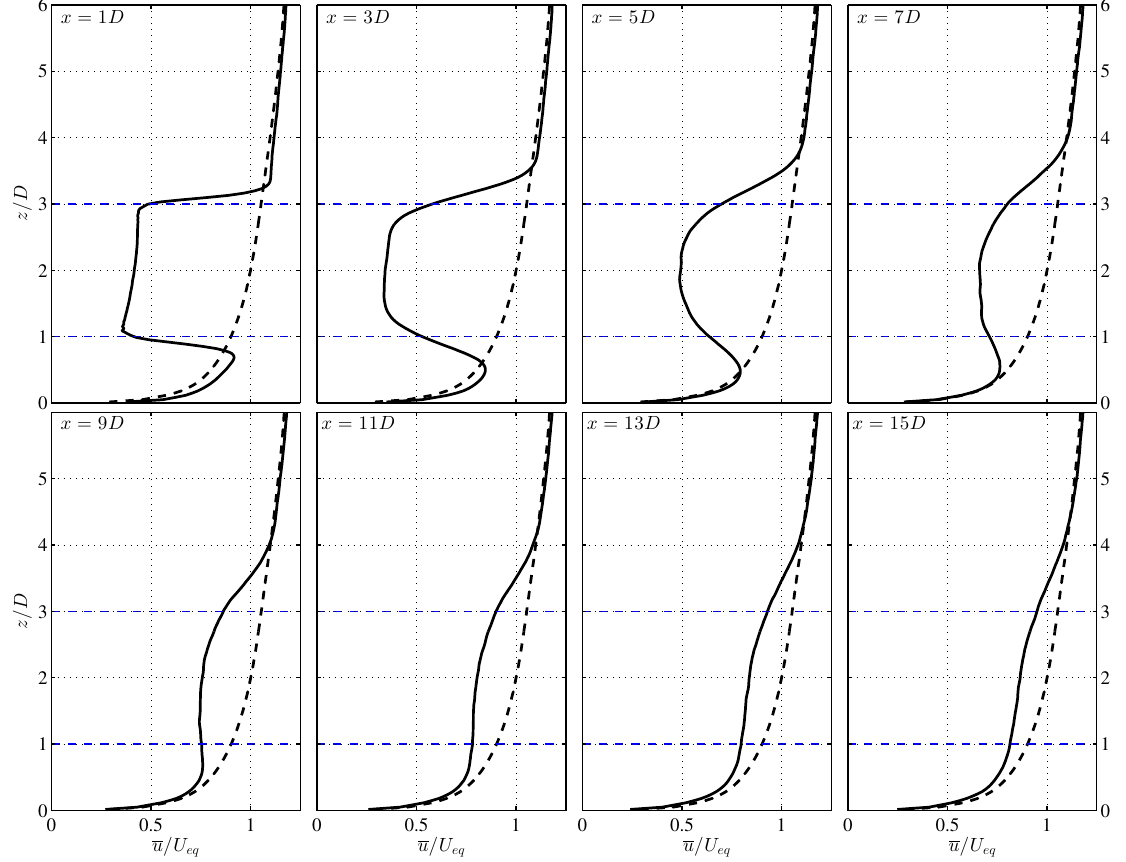
Figure 10. Vertical profiles of the normalized mean streamwise velocity ( u / U eq ) in the x - z plane going through the center of the turbine at different downstream positions. The black dashed line represents the inflow profile, and the blue horizontal dashed lines show the extent of the